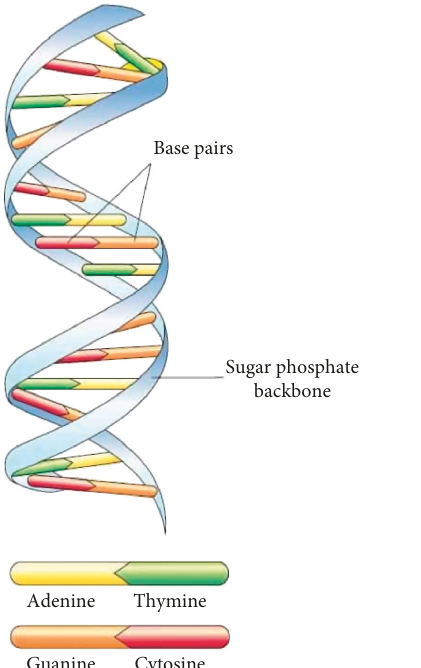
Figure 2: Structure of DNA (Image source: US National Library of Medicine).